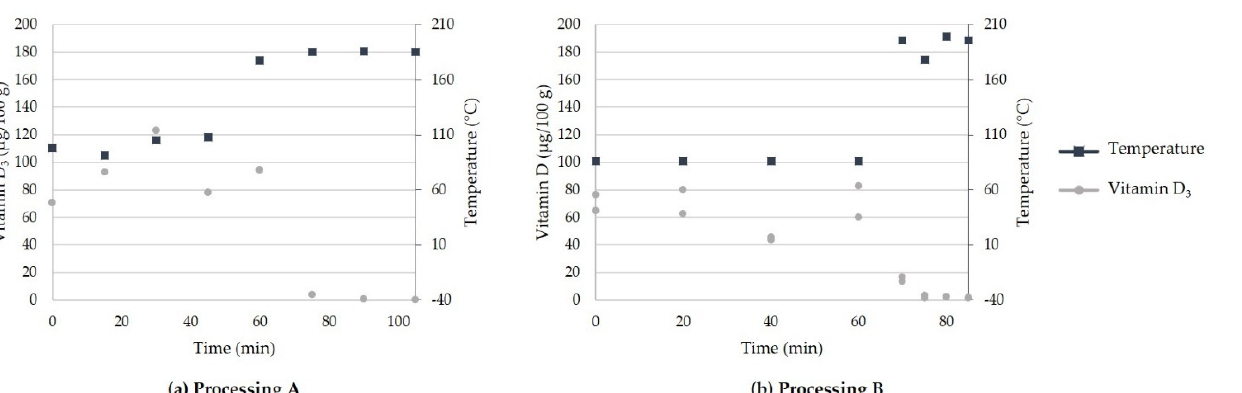
Table 2. Reproducibility of UVB exposure after thermal processing B. Each exposed group consisted of 10 pork cracklings, each analyzed in triplicate. The content of vitamin D 3 is shown as mean ± SD. Exposed Group